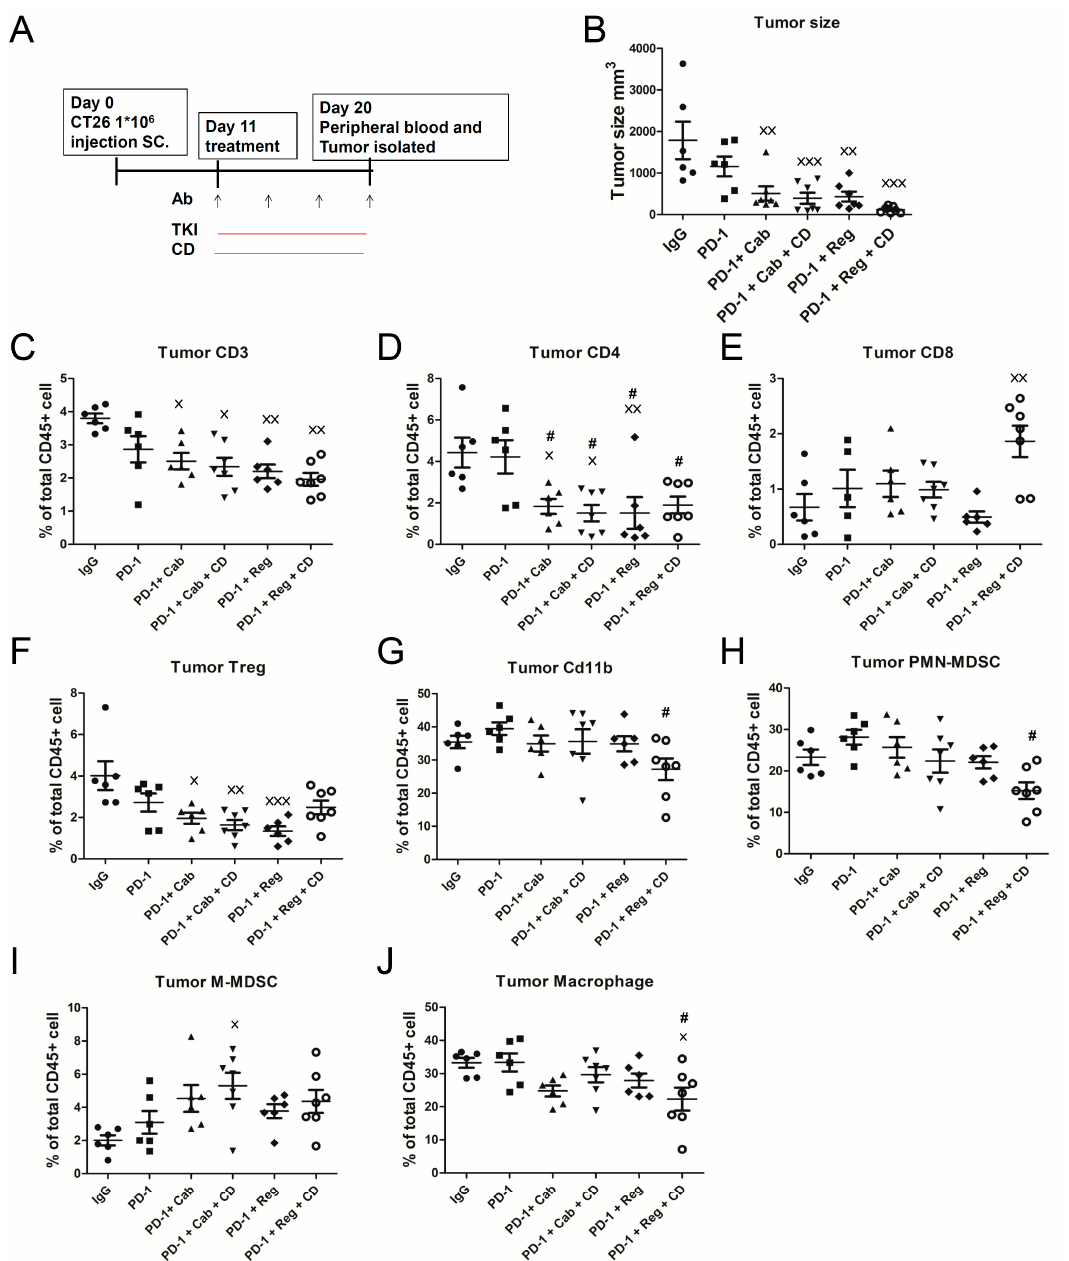
Figure 2. Immunosuppressive cells in microenvironment were attenuated by anti-PD-1 +TKI +CD- k30 treatment. ( C – J ) show the results of immune cell population analysis of lymphocytes and myeloid-derived MDSCs in the CT26-bearing mice tumors. The CT26 tumor-bearing mice were treated with various therapeutic modalities as indicated. Tumor samples were isolated on day 20 after 9-day treatment for analyzing immune cell population in tumors. ( A ) Consecutive treatment schedule and ( B ) Tumor sizes of each treatment group. ( C – F ) show the results of flow cytometry of CD3, CD4, CD8, and Treg cell population in tumors. ( G – J ) show the results of flow cytometry of myeloid-derived CD11b, PMN-MDSC, M-MDSC, and tumor association macrophage (TAM) cell populations in tumors. Results are shown as mean + SD; × p < 0.05, ×× p < 0.01, ××× p < 0.001, one- way ANOVA with Tukey’s test. × , compared to IgG; #, compared to PD-1 ( n = 6–7). Gene expression analysis of CT26 tumors revealed that multiple immune-related pathways were induced following treatment with anti-PD-1 antibody combined with cabozantinib/regorafenib, with or without chidamide. The consecutive treatment